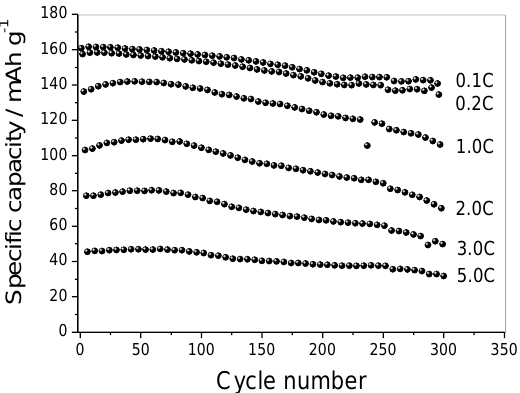
Figure 10. Discharge specific capacity as a function of the cycle number for the cell made with the PANPCL_02 separator.